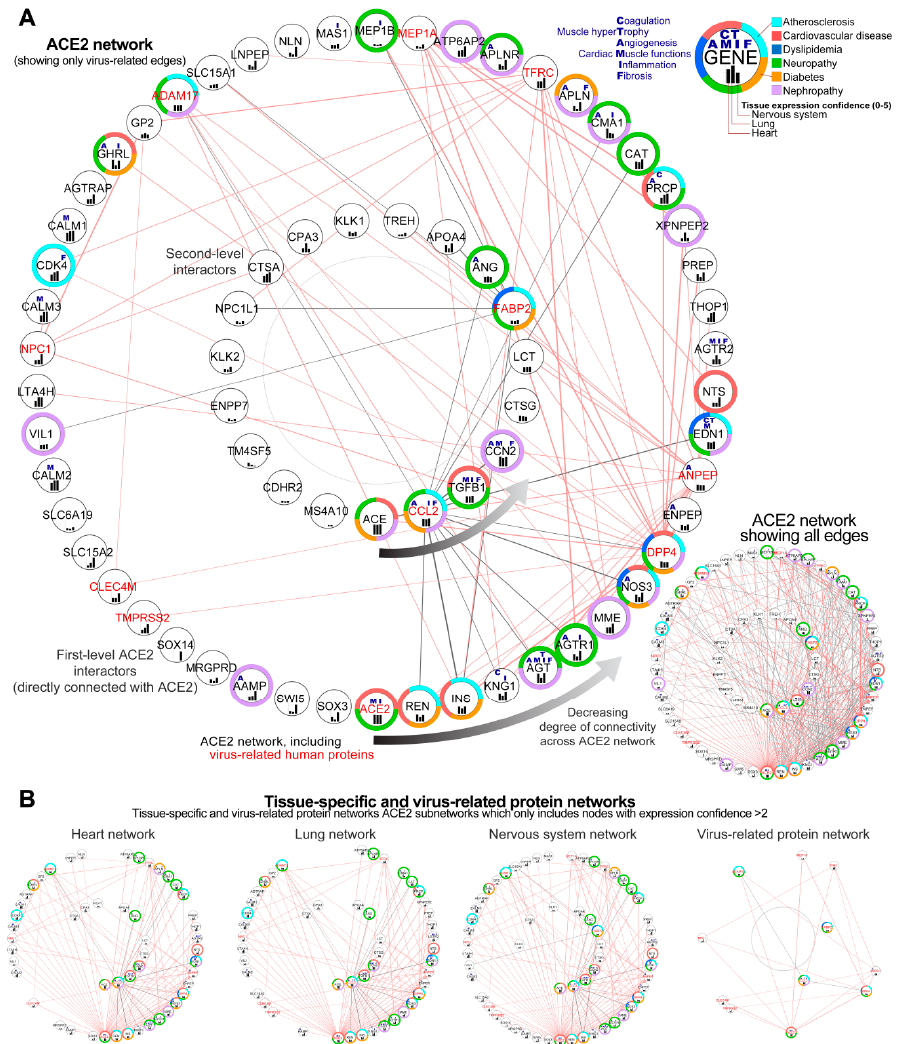
Figure 3. Predicted ACE2 (Angiotensin-Converting Enzyme 2) interaction network. ( A ) Complete ACE2 network visualized as two circles ordered by the number of connections (degree) with other nodes. A circular degree-sorted layout was used to enable us to hide the edges to simplify visualization. The external circle depicts the first level ACE2 interactors; the internal circle depicts the second level of interactors, with genes that do not connect directly with ACE2. For clarity, on the main figure, we showed only the edges associated with virus-related proteins (gene id in red). Edges associated with virus-related proteins are shown in red for first-level (direct) and in grey for the second-level (indirect) ACE2 interactors. Inset in the top right depicts the additional information for each gene / protein, as associated processes (blue letters), associated diseases (color-label ring), and expression confidence across key tissues (black bars). Inset in the bottom right depicts the same network including all edges. Genes present on the bottom, toward the right of the circular network, showed the highest connectivity within the network. Notice that the closest ACE2 interactors are ACE (Angiotensin-Converting Enzyme 1), renin (REN) and inulin (INS), which play a central role in the pathophysiology of a number of cardiovascular disorders. The following interactor is KNG1 (Kininogen 1), essential for blood coagulation and assembly of the kallikrein-kinin system and AGT (Angiotensinogen) influencing the renin-angiotensin system (RAS) function. In the network are present 11 virus-infection-related proteins (red labels) forming a dense connection with ACE2 and its top interactors which can a ff ect its functionality. ( B ) Subsets of ACE2 network containing only highly expressed proteins in the heart, lung, and nervous system; analogous network for virus-related proteins (right). From the genes which did not have direct interactions with ACE2, the gene ACE showed the highest